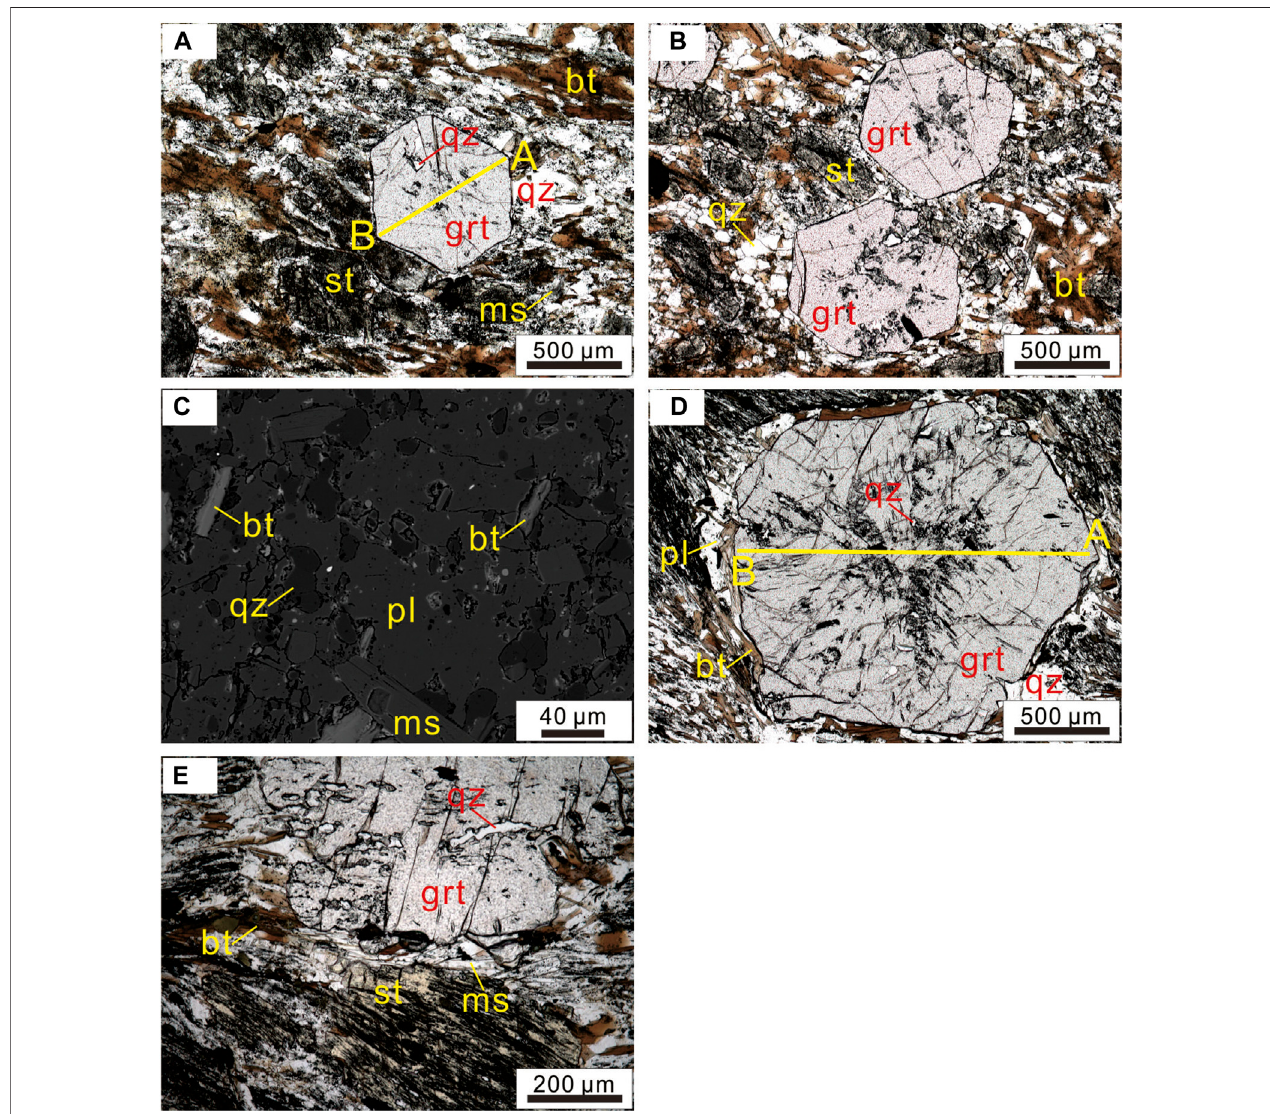
FIGURE 4 | Mineral assemblages and microstructures of garnet – staurolite – two-mica schist in the Ramba gneiss dome. (A,B) Photomicrographs to show garnet and staurolite porphyroblasts and matrix minerals, including biotite, muscovite, plagioclase, and quartz in sample RB12-19 (plane-polarized light). (C) Photomicrograph toshowbiotite,muscovite,quartz,andplagioclaseinsampleRB12-19(back-scatteredelectronimage). (D) Photomicrographtoshowgarnetporphyroblastsandmatrix minerals, including biotite, muscovite, plagioclase, and quartz in the sample RB12-24 (plane-polarized light). (E) Photomicrographs to show garnet and staurolite porphyroblasts and matrix minerals, including biotite, muscovite, plagioclase, and quartz in sample RB12-24 (plane-polarized light).